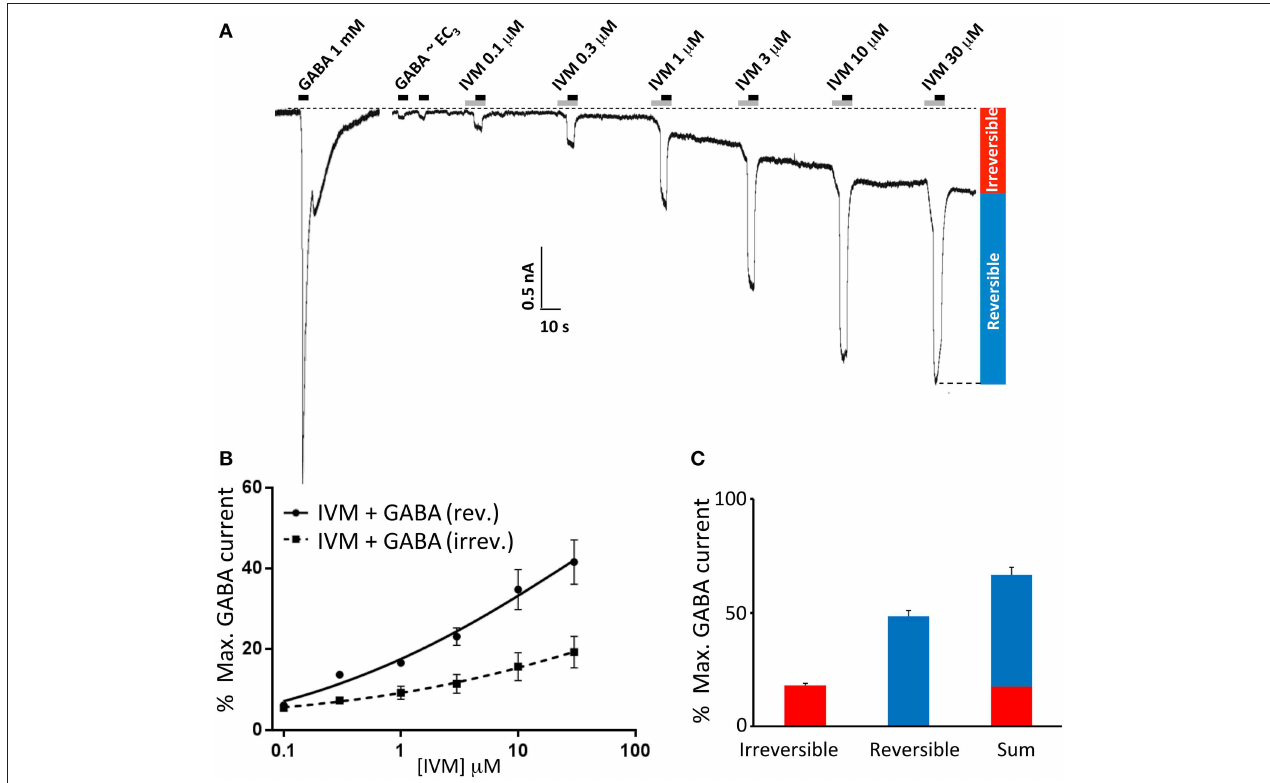
FIGURE 1 | Ivermectin modulation of wild type α 1 β 2 γ 2L GABA A Rs. In this and subsequent figures, all displayed traces were recorded from HEK293 cells expressing WT or mutated α 1 β 2 γ 2L receptors using whole cell recording, and the durations of ivermectin and GABA applications are indicated by gray and black bars, respectively. (A) Sample recording showing the effect of repeated applications of EC 3 GABA together with increasing concentrations of ivermectin at 1min intervals as indicated. A current response to saturating GABA from the same cell is also shown. (B) Averaged ivermectin concentration-response relationships from 4 to 5 cells, with error bars shown as SEM. Ivermectin-induced reversible and irreversible currents, measured as shown in (B) , are plotted separately as circles and squares, respectively. (C) Mean saturating magnitudes of reversible and irreversible ivermectin-modulated currents (defined as indicated in A ), and their sum, plotted as a percentage of the saturating GABA-activated current. Mean GABA EC 50 , n H and I max values for this and all other constructs are provided in Table 1 .